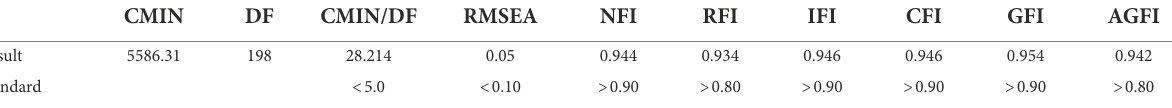
TABLE 7 Goodness of